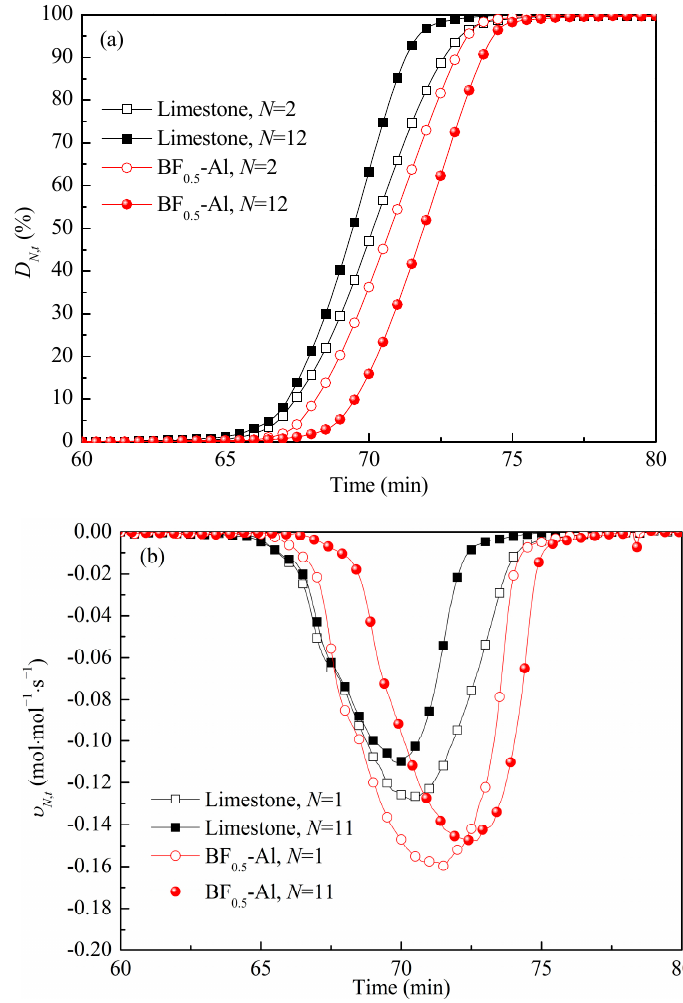
Figure 7. Decomposition kinetics in the 2nd and 12th cycles: ( a ) the time evolution of decomposition ratio; ( b ) the time evolution of decomposition rate.